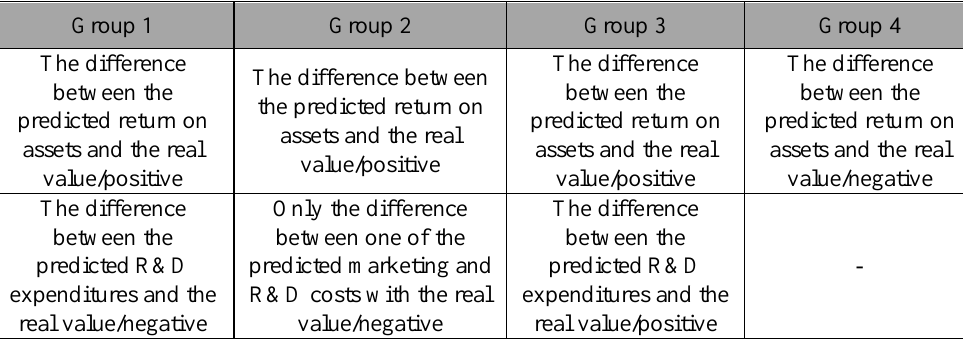
Table 2. Measurement of managers’ myopic